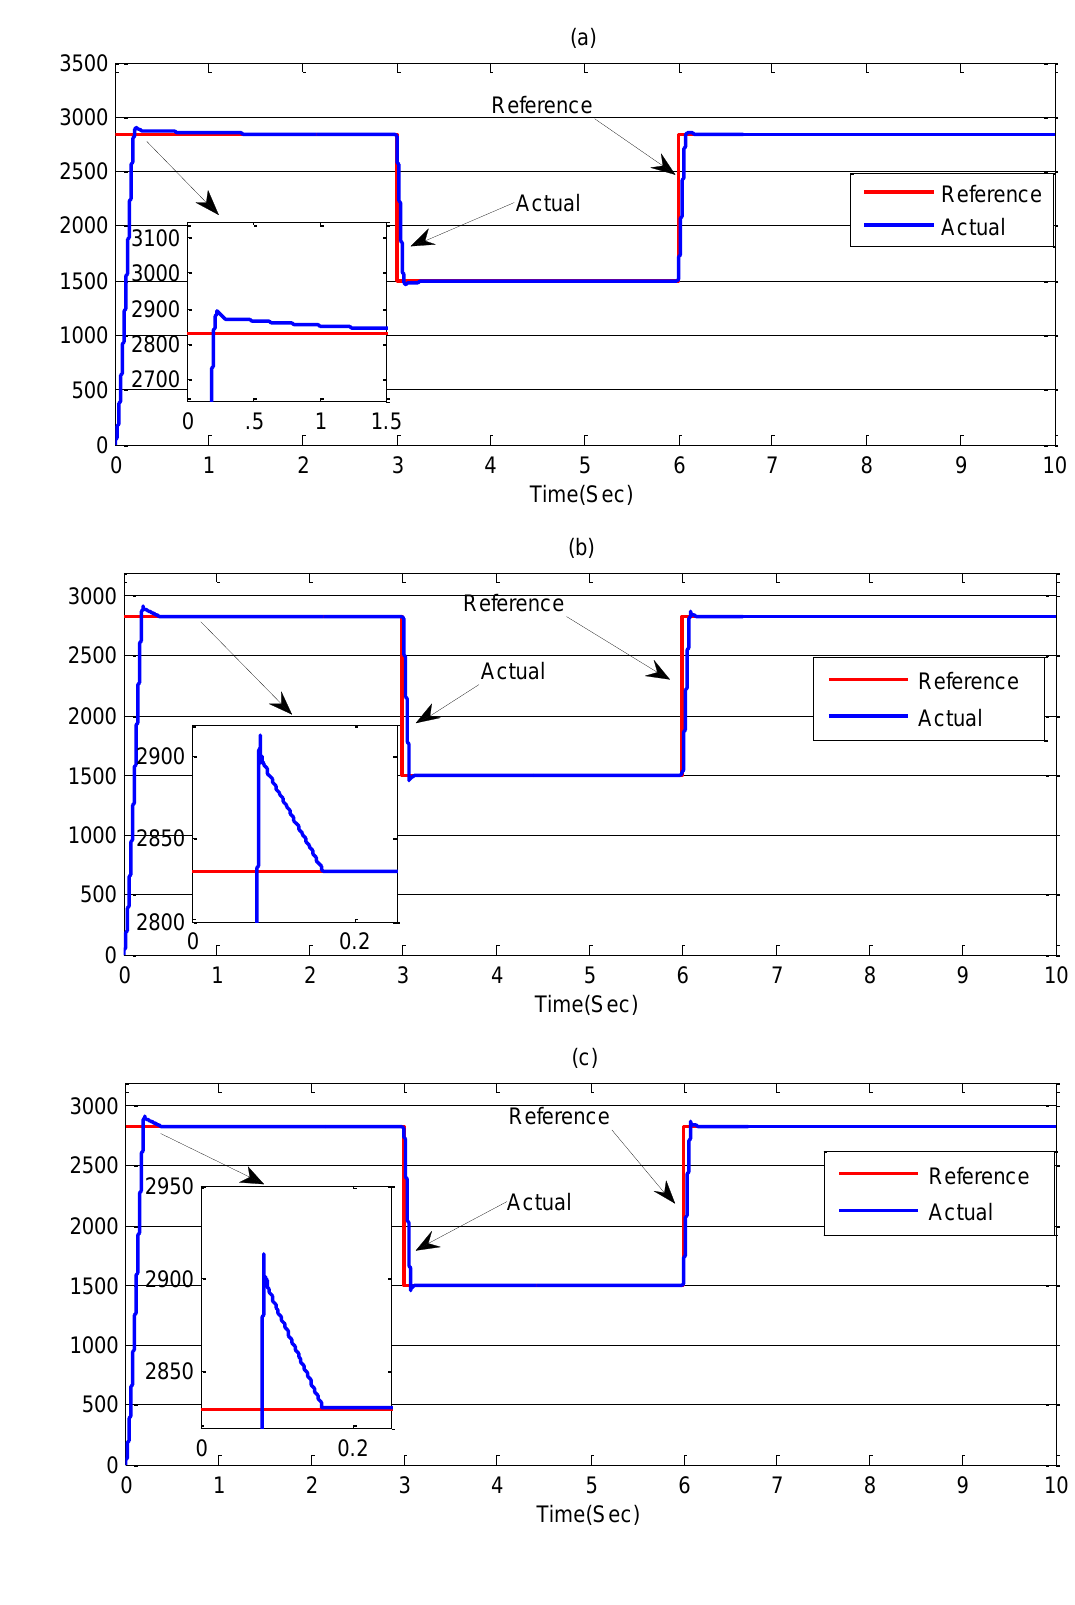
Figure 7. Simulated speed responses-based IM drive at no load in Case-1 ; ( a ) the tuned PI controller, ( b ) the conventional BLFC controller, and ( c ) the proposed NBLFC